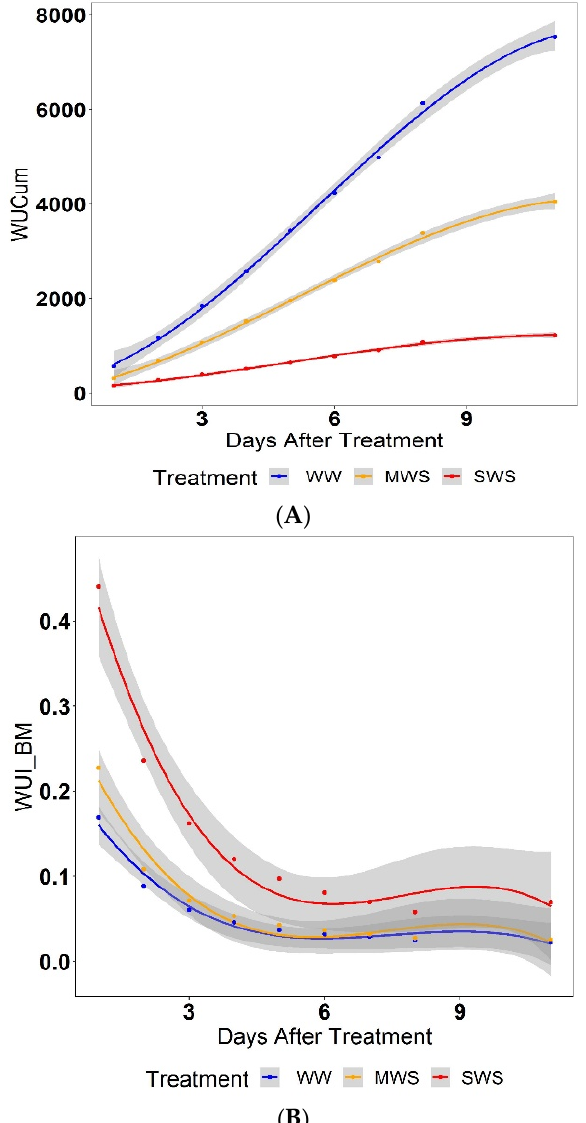
Figure 3. Water use indices at different levels of water stress. ( A ) cumulative water use (WUCum), ( B ) Biomass based water use index (WU_BM) in well-watered (WW), moderate water stress (MWS) and severe water stress (SWS) treatments; WUCum represents the cumulative water use in mL plant − 1 at particular time of growth, while WUI_BM computed as the predicted biomass per unit of water use (mg mL − 1 ) as presented in material and methods. Solid lines represent the means of all genotypes while the shaded part indicates the CI at 0.95.